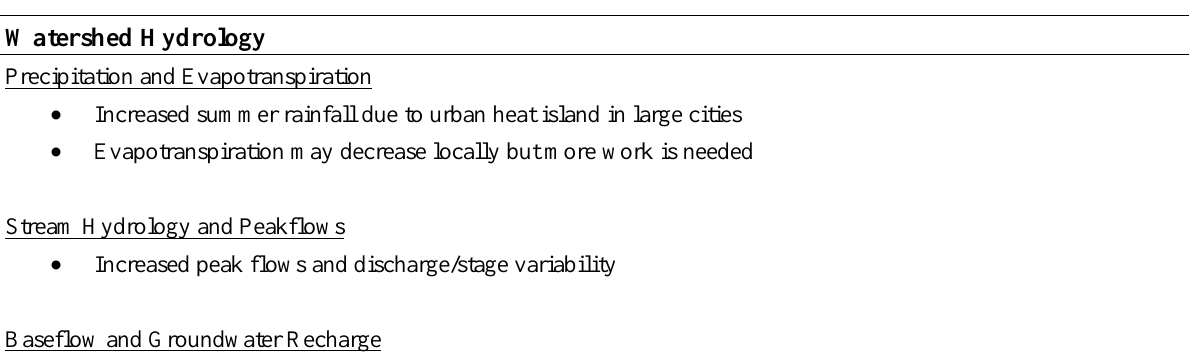
Table 3. Common alterations to watershed hydrology and in-stream processes in response to urbanization in the southern